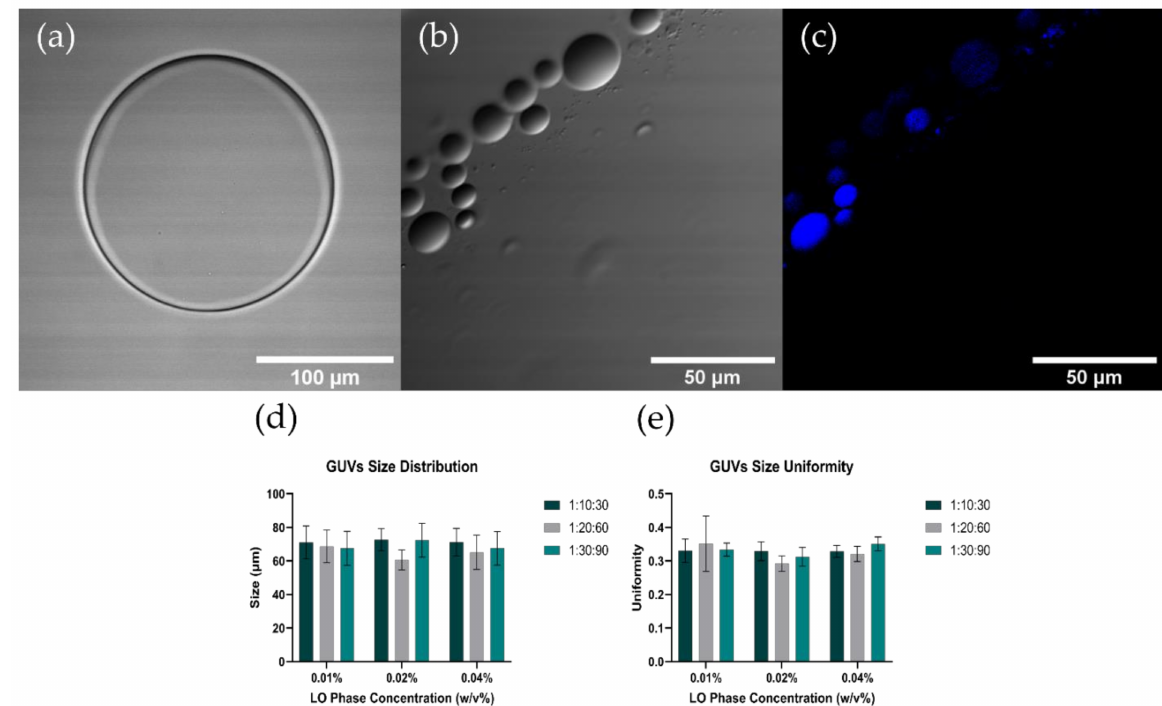
Figure 6. GUVs size and shape characterization. ( a – c ) CLSM images of GUVs. ( d ) SLS GUVs size distribution and ( e ) uniformity